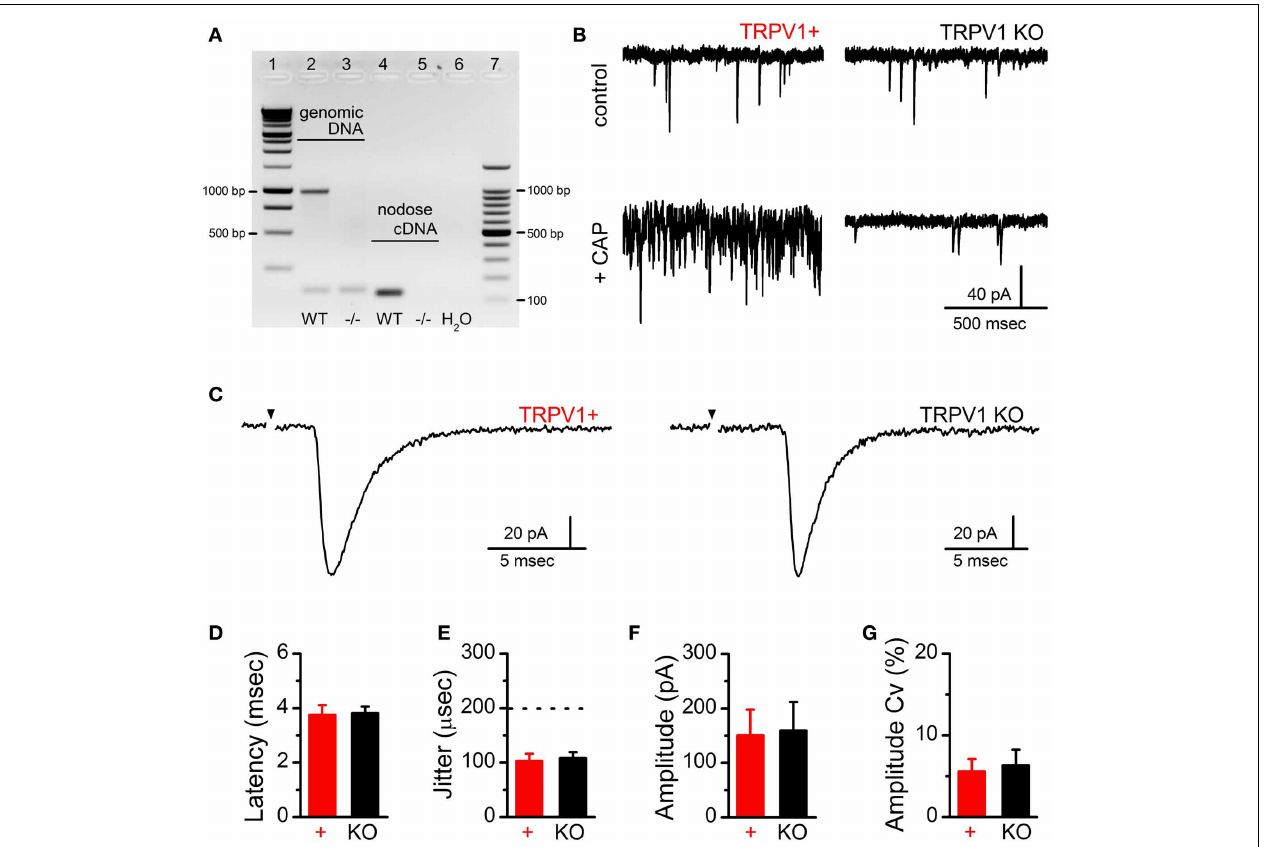
FIGURE 1 | Confirmation of TRPV1 deletion and comparison of ST-evoked synchronous glutamate release between primary afferent contacts onto second-order NTS neurons from control and TRPV1 KO animals. (A) Gel electrophoresis showing the TRPV1 specific genomic DNA (predicted band at 984bp) and nodose cDNA (predicted band at 134bp) amplicon from control and TRPV1 KO mice. (B) Currents traces showing sEPSC frequency in control bath (upper panels) and following CAP (100nM) exposure (lower panels) from TRPV1 + (left) and TRPV1 KO afferents. (C) Current traces comparing ST-evoked synchronous glutamate release from single ST afferent inputs confirmed to express TRPV1 (CAP sensitive) or from TRPV1 KO mice. Traces are of individual sweeps with the black arrow